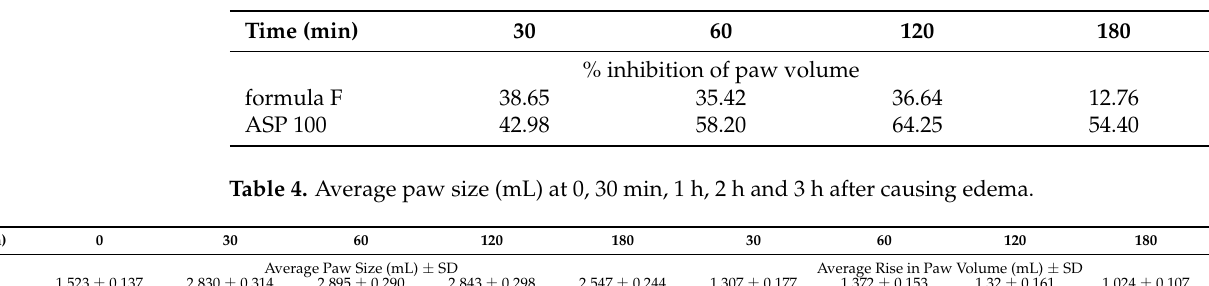
Table 3. Anti-inflammatory activity of formula F on egg white-induced rat paw edema.